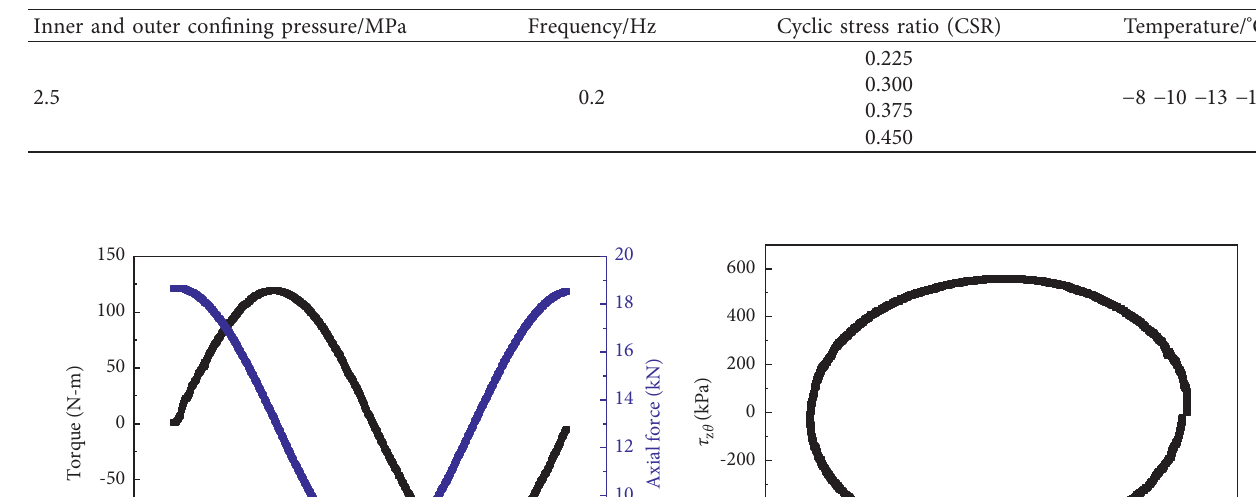
Table 2: Conditions of tests on frozen clay.